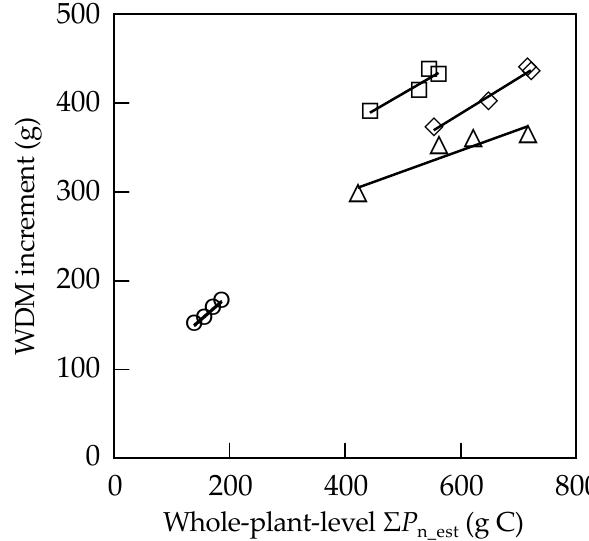
Figure 1. Relationships between the whole-plant-level Σ P n_est and whole-plant dry mass (WDM) increment over the two growing seasons. Solid lines indicate the regression line for each